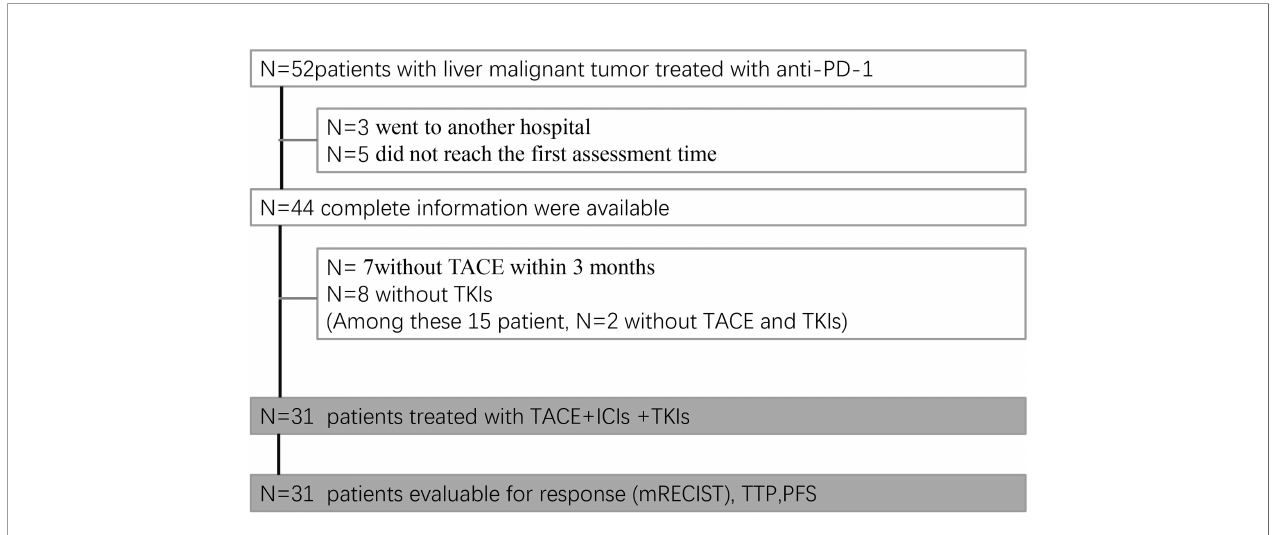
FIGURE 1 | Patient fl ow